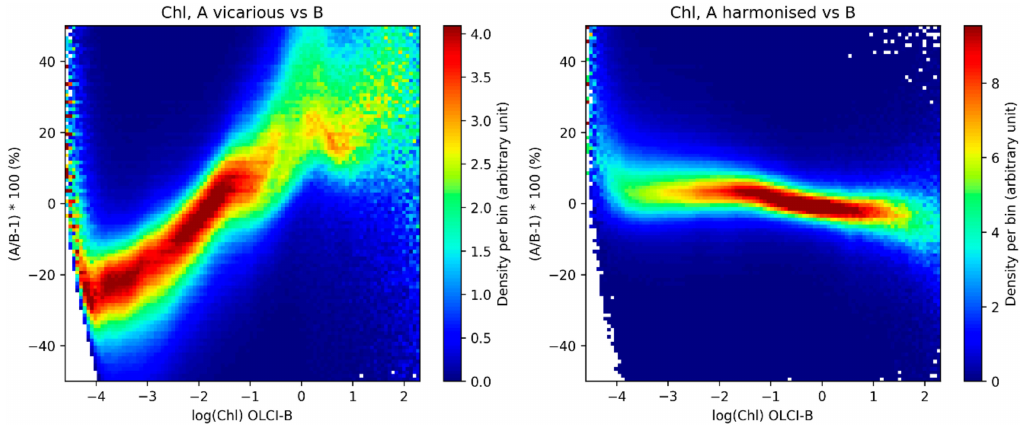
Figure 18. Chl (natural unit) relative di ff erences between OLCI-A ( left : baseline, right : harmonised) and OLCI-B from all L3 composites over the tandem period as a function of Chl (log unit to embrace the full dynamics). Results are shown as histograms per bin of the corresponding parameter with OLCI-B taken as